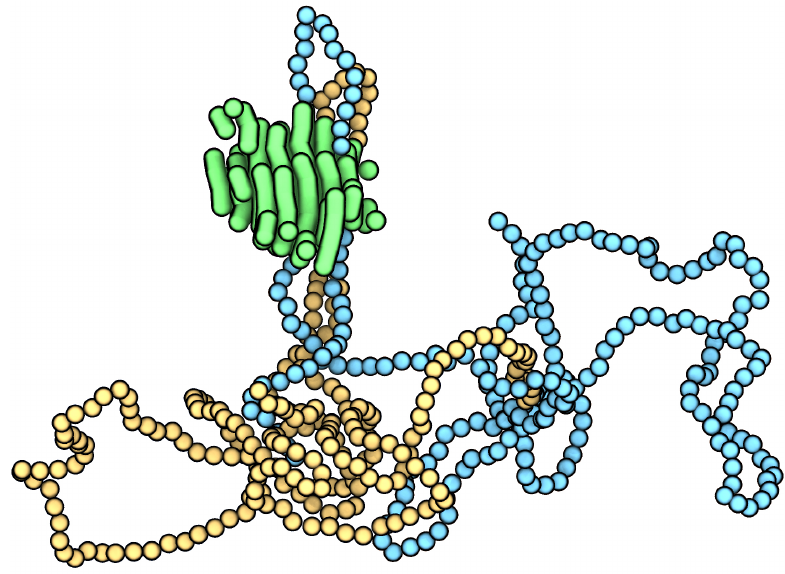
Figure 1. A nascent polyethylene lamella approximately 3 nm across as extracted from one of the nucleation simulations used in this study. The green tubes correspond to the stems composing the crystalline cluster. Note that the cluster is composed of sections of multiple chains. The surrounding polymer melt is not shown for visual clarity. The yellow and blue spheres correspond to two folded polymer chains that traverse the nascent lamella. The folds correspond to the two loops at the top of the cluster. All of the blue and yellow spheres correspond to non-crystalline polymer chain